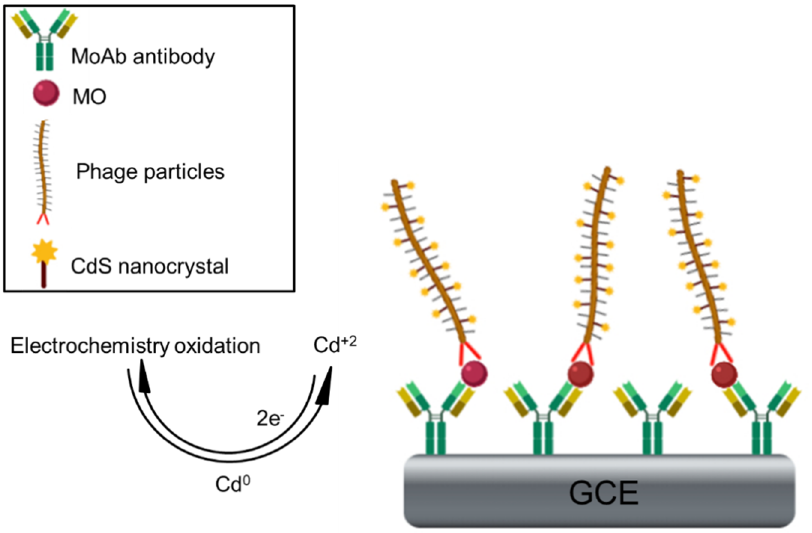
Figure 4. Schematic representation of electrochemical immunosensor for MON detection based on phage particles labelled with CdS nanoparticles.